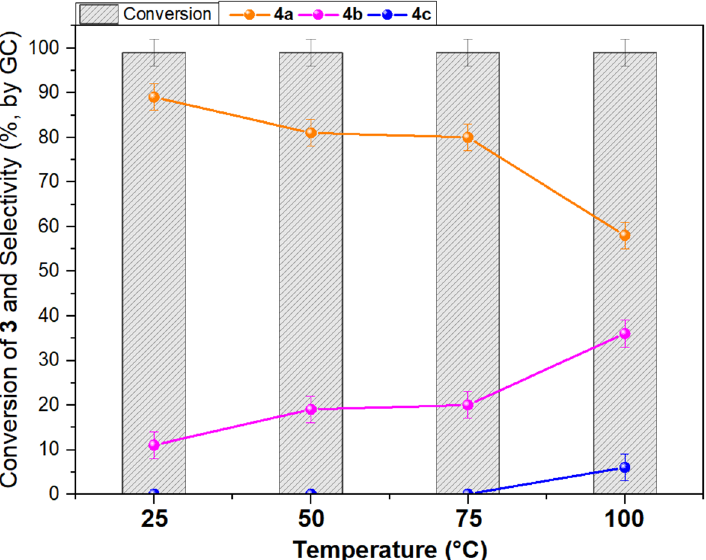
Figure 7. Effect of temperature in the reductive amination of furfural. Reaction conditions: 3 (0.1 M in methanol), catalyst (50 mg), 30 bar H 2 , flow rate (0.3 mL min − 1 ). Conversion and selectivity were determined by GC.